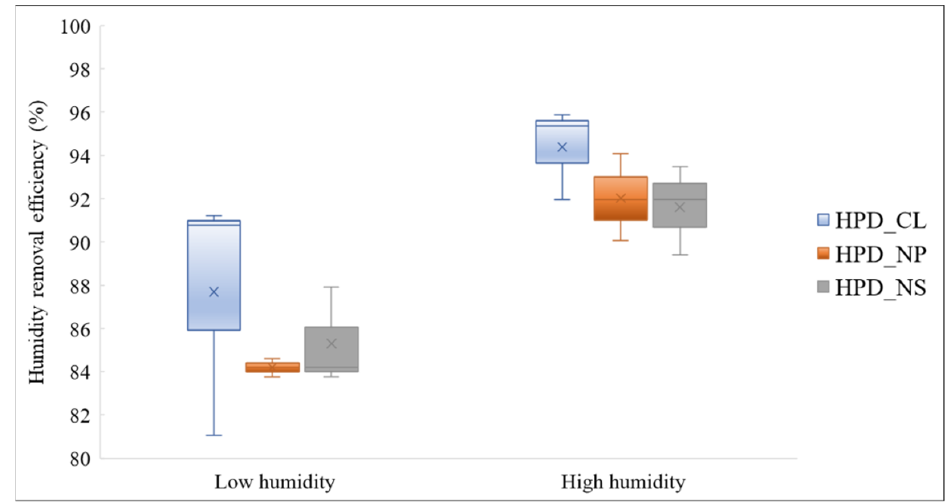
Figure 3. Humidity removal efficiency of humidity pretreatment devices operated at room temperature with respect to low (4%) and high (17%) humidity.